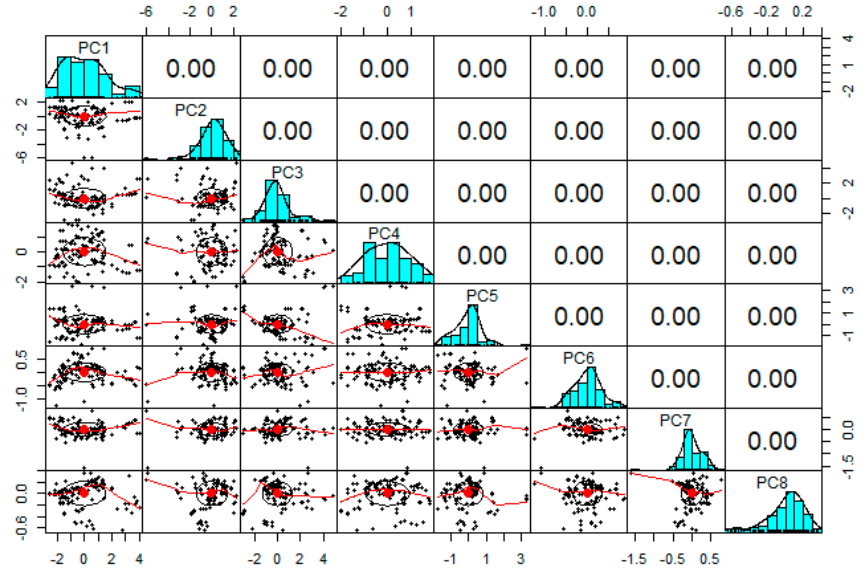
Figure 6. Pair plot of PCs.